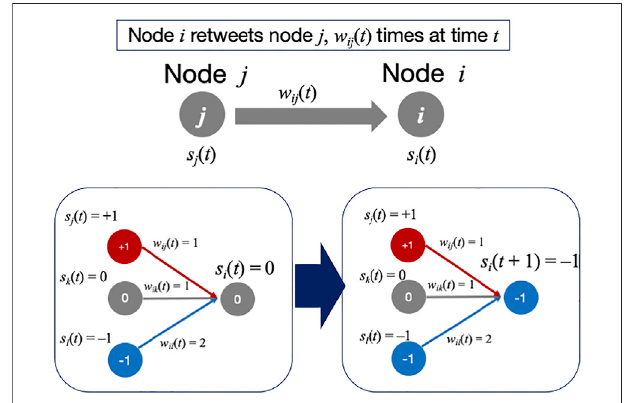
FIGURE 1 | (A) An example of drawing directed and weighted link from tweets. (B) Our opinion model. An example where the node i changes its opinion s i ( t ) at time t +